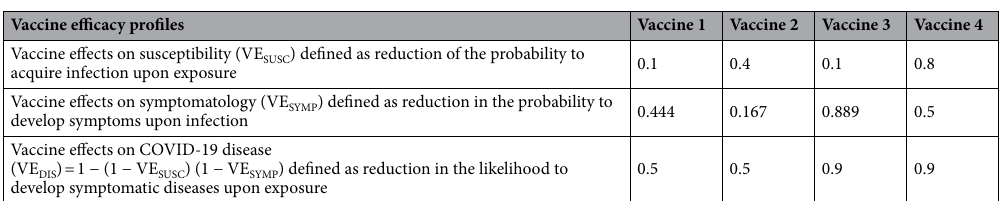
Table 1. Vaccine efficacy profiles simulated in the main analysis. All profiles assume no reduction in infectiousness (VE INF =